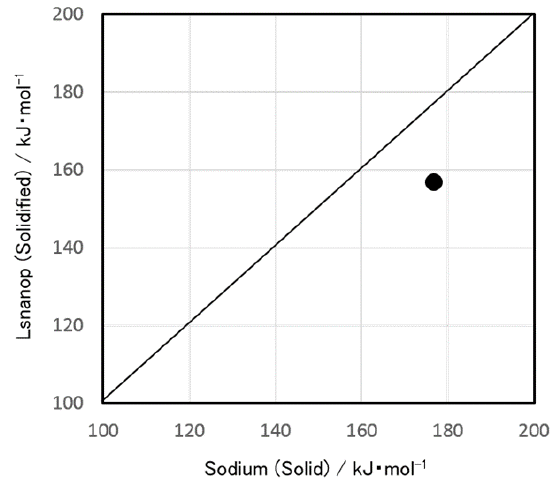
Figure 8. Comparison of the absolute values of heat of the reaction to water between the LSnanop (solidified) and solid Na: The slanted line corresponds to the case in which the heat of reaction to water is the same for the LSnanop and liquid